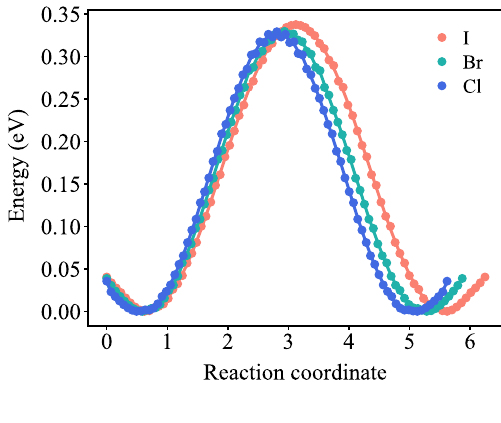
Fig. 2 Calculated potential energy surface for vacancy- assisted V + X halide migration in CsPbX . This is the lowest 3 energy path extracted from the 2D potential energy surface. The corresponding barriers are given in Table 1